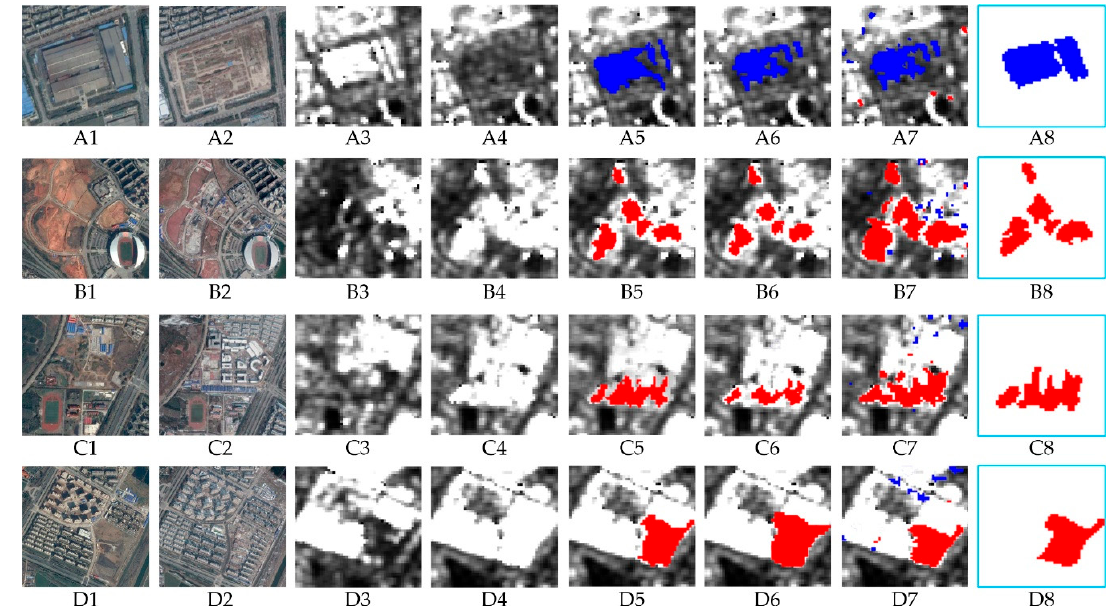
Figure 8. Detailed results of different methods at the test site in Jiangning District. All positive change